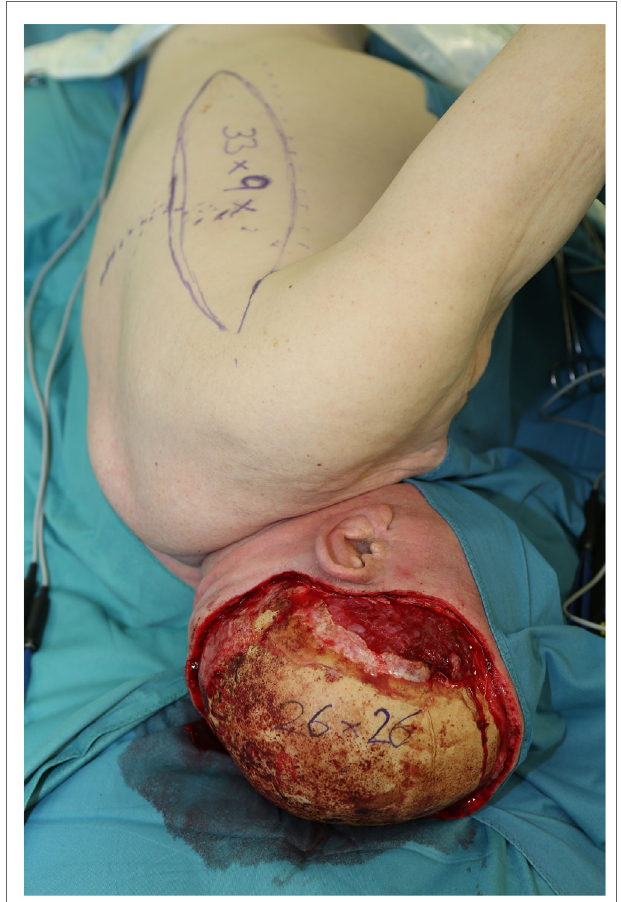
FiGURe 6 | intraoperative view after total full thickness scalp resection due to an angiosarcoma . Note the 26 cm × 26 cm sized defect and the planned parascapular flap with a size of 33 cm × 9 cm.